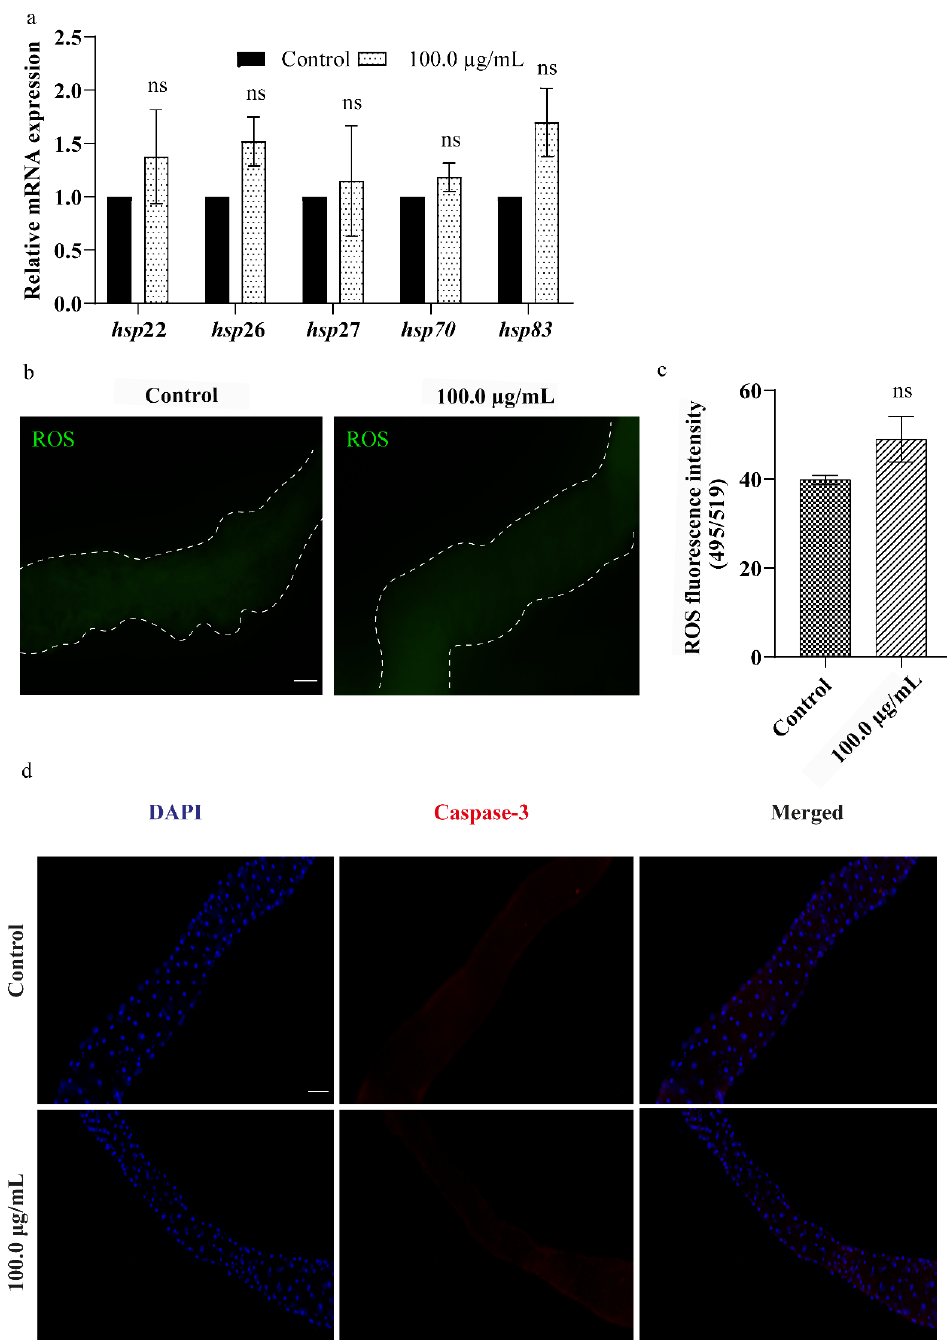
Figure 6. Effect of A.L. extract of C.orchioides at cellular level: ( a ) hsps expression. The graph represents non-significant hsps expression in the gut of larvae exposed to A.L. extract. ( b , c ) ROS generation. The graph represents no major change in intensity of DCF fluorescence in control and A.L. extract-treated groups. ( d ) Apoptotic assay. The graph illustrates no cell death observed in the gut of control larvae and the highest concentration of A.L. extract ‐ fed larval gut (100.0 μ g/mL). The gut tissues are stained with DAPI. Significance is ascribed as ns p > 0.05. The scale bar corresponds to 100 μ m.